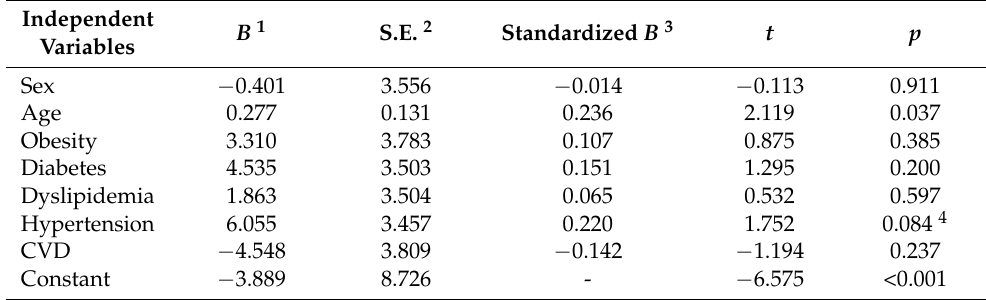
Table 6. Results of multilinear regression model ( stepwise ) that was designed using the number of days an individual remained in the ICU as the dependent